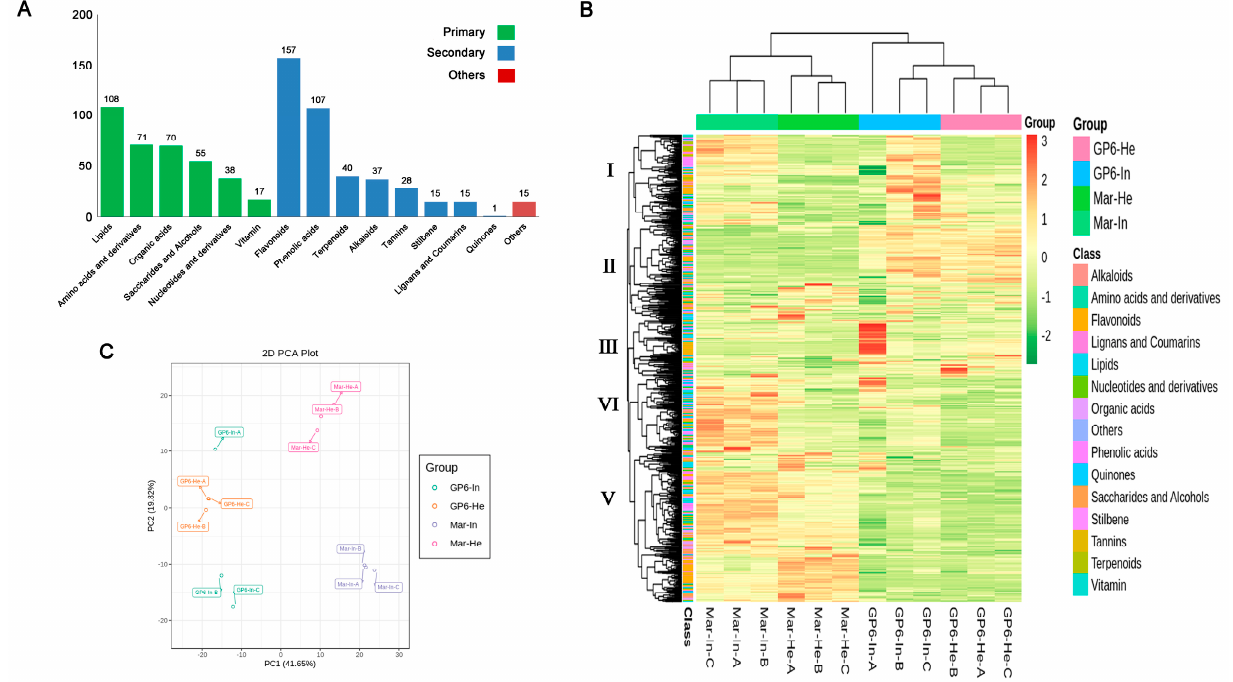
Figure 2. ( A ) Classification of the 774 metabolites of grape berry samples; ( B ) hierarchical cluster analysis (HCA); ( C ) principal component analysis